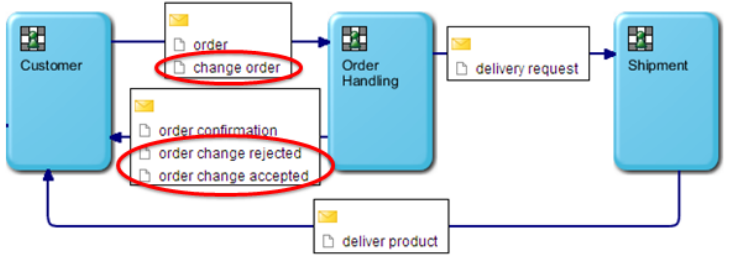
Figure 12 . Interaction Diagram including changed